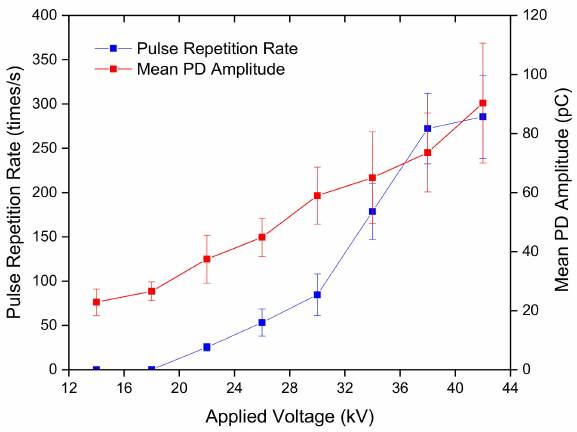
Figure 5. PD parameters under AC/DC proportion of 1:1.